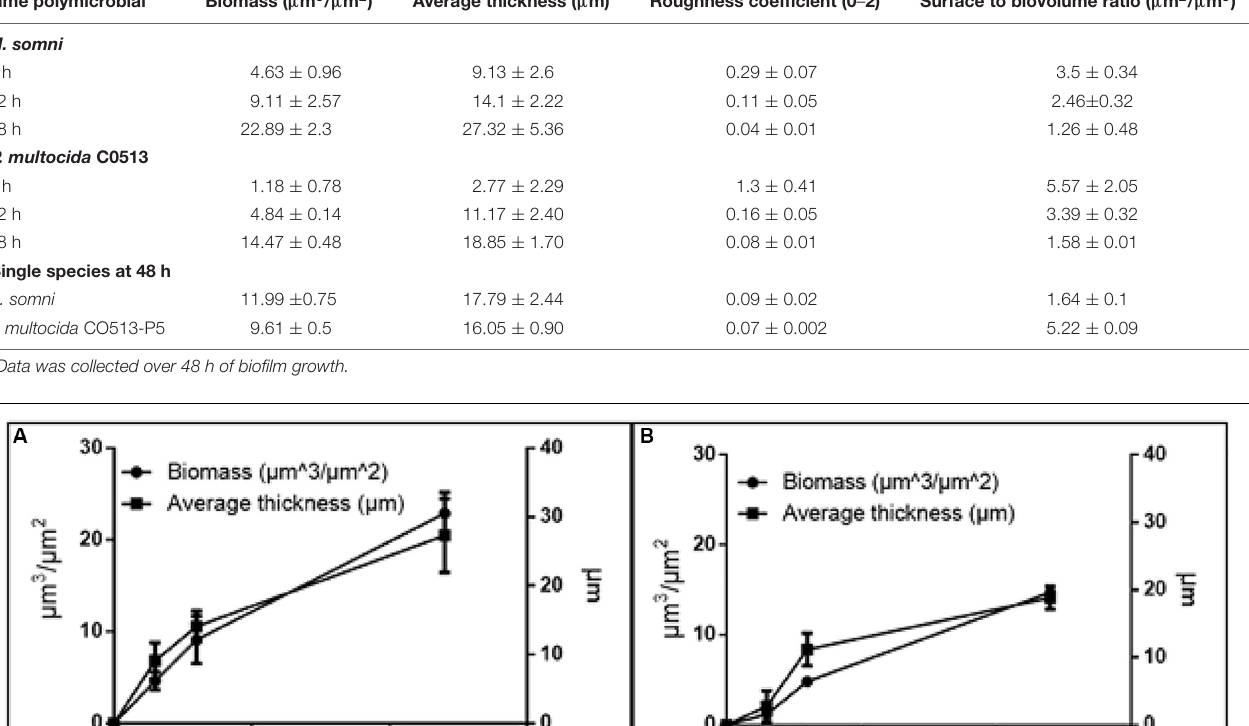
Time polymicrobial Biomass ( µ m 3 / µ m 2 ) Average thickness ( µ m) Roughness coefficient (0 – 2)